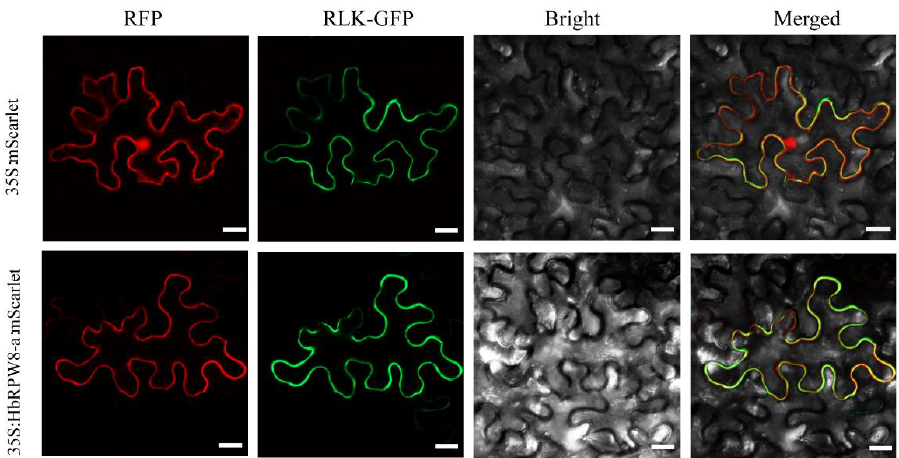
Figure 3. Subcellular localization of HbRPW8-a protein by transient expression in tobacco epidermal cells. The plasma membrane localized AtRLK-GFP was used as positive control. The 35S: mScarlet empty vector was used as negative control. Scale bar = 20 μm.